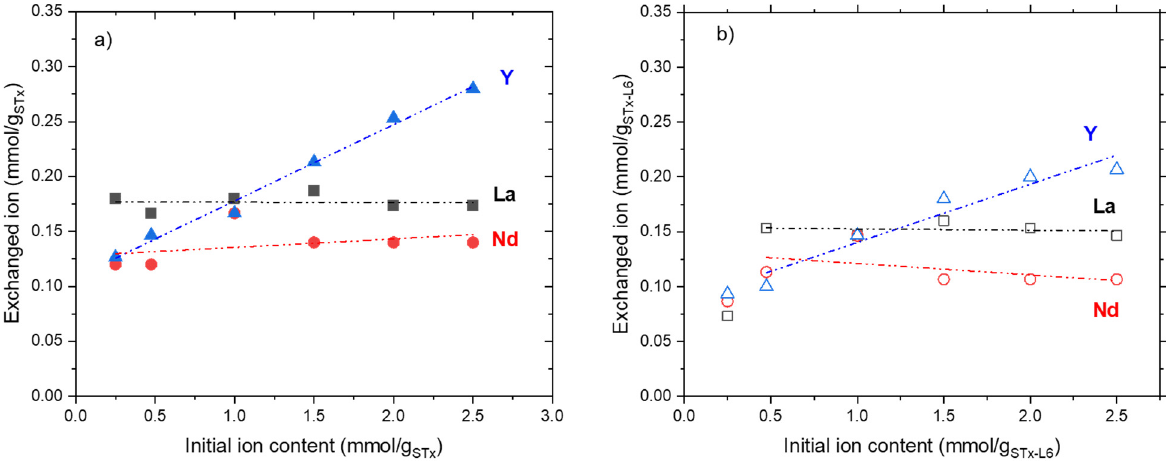
Figure 3. Exchanged ions as a function of the initial ion contents for: ( a ) pristine STx and ( b ) modified STx-L6.